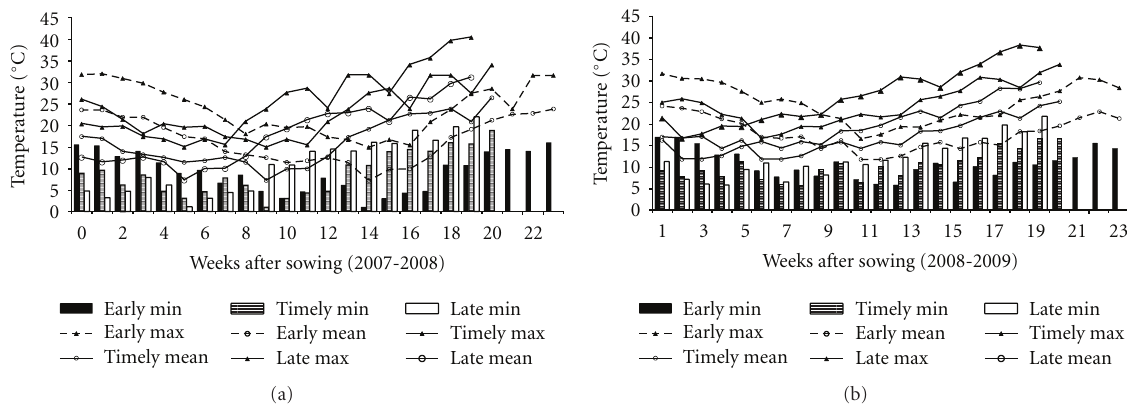
Figure 2: Patterns of weekly temperatures during the wheat growing season for the year 2007-2008 (year I) and 2008-2009 (year II). Table 1: E ff ect of sowing time on test weight and grain plumpness of drought-susceptible (PBW 343) and drought-tolerant (C 306) wheat genotypes grown under irrigated and rain-fed conditions. Values are mean ± standard deviation of three plots; CD, critical di ff erence; hl, hectoliter; NS, not